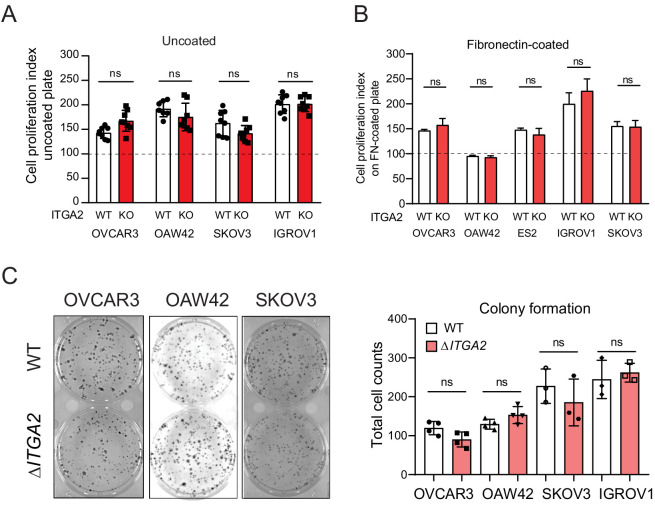
The dependence of ECM in cell proliferation and colony formation assay.(A) Cell proliferation index of WT and ΔITGA2 cells in fibronectin-coated and (B) uncoated tissue culture plate. Nunc-Maxisorp 96-well plates were used to coat for 2 μg of fibronectin before seeding cells for proliferation assay. (C) Anchorage-dependent colony formation for WT and ΔITGA2 cells after 7 days in uncoated tissue culture plate. Bar chart represents the mean ± SD of total colony counts. Representative images show colony formation in standard tissue culture plate.